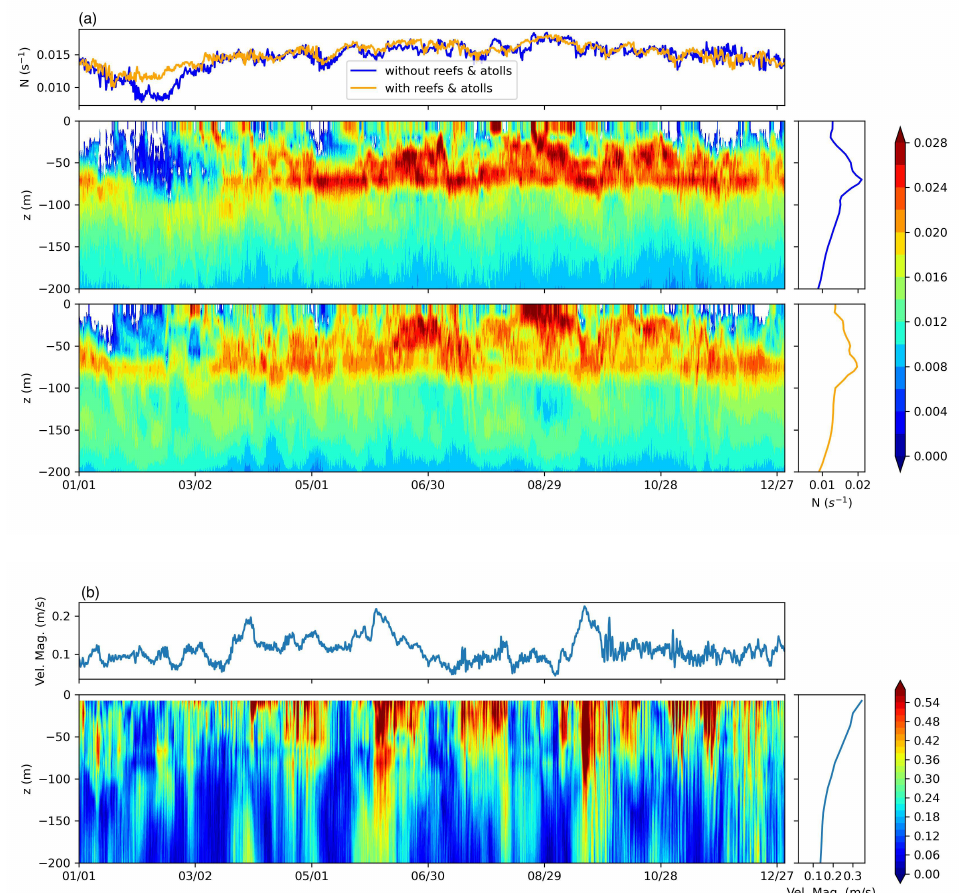
Figure 8. Time sequences for: ( a ) vertical distribution of the regional mean Brunt–Väisälä frequency N sampled in the XA area and ( b ) horizontal velocity magnitudes (in m/s) sampled at Point C (the location is depicted in Figure 2d) during 2009.